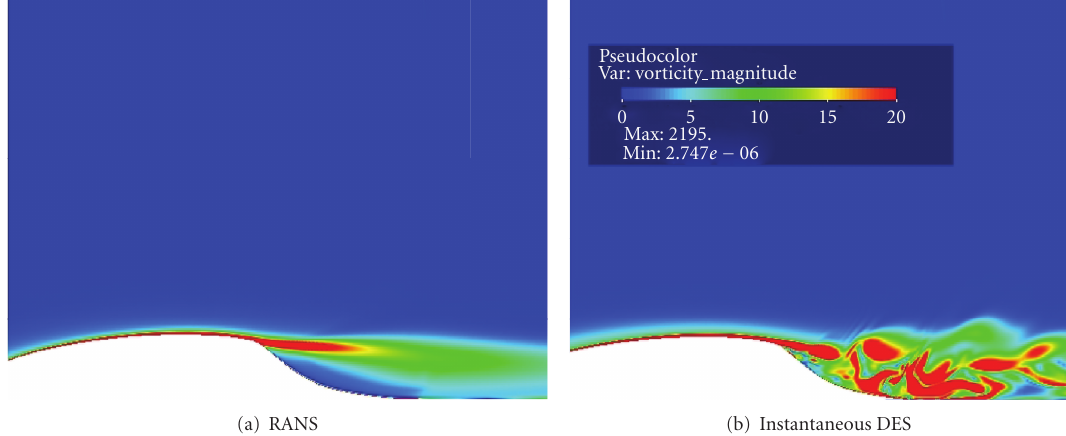
Figure 12: Spanwise averaged vorticity magnitude contours.